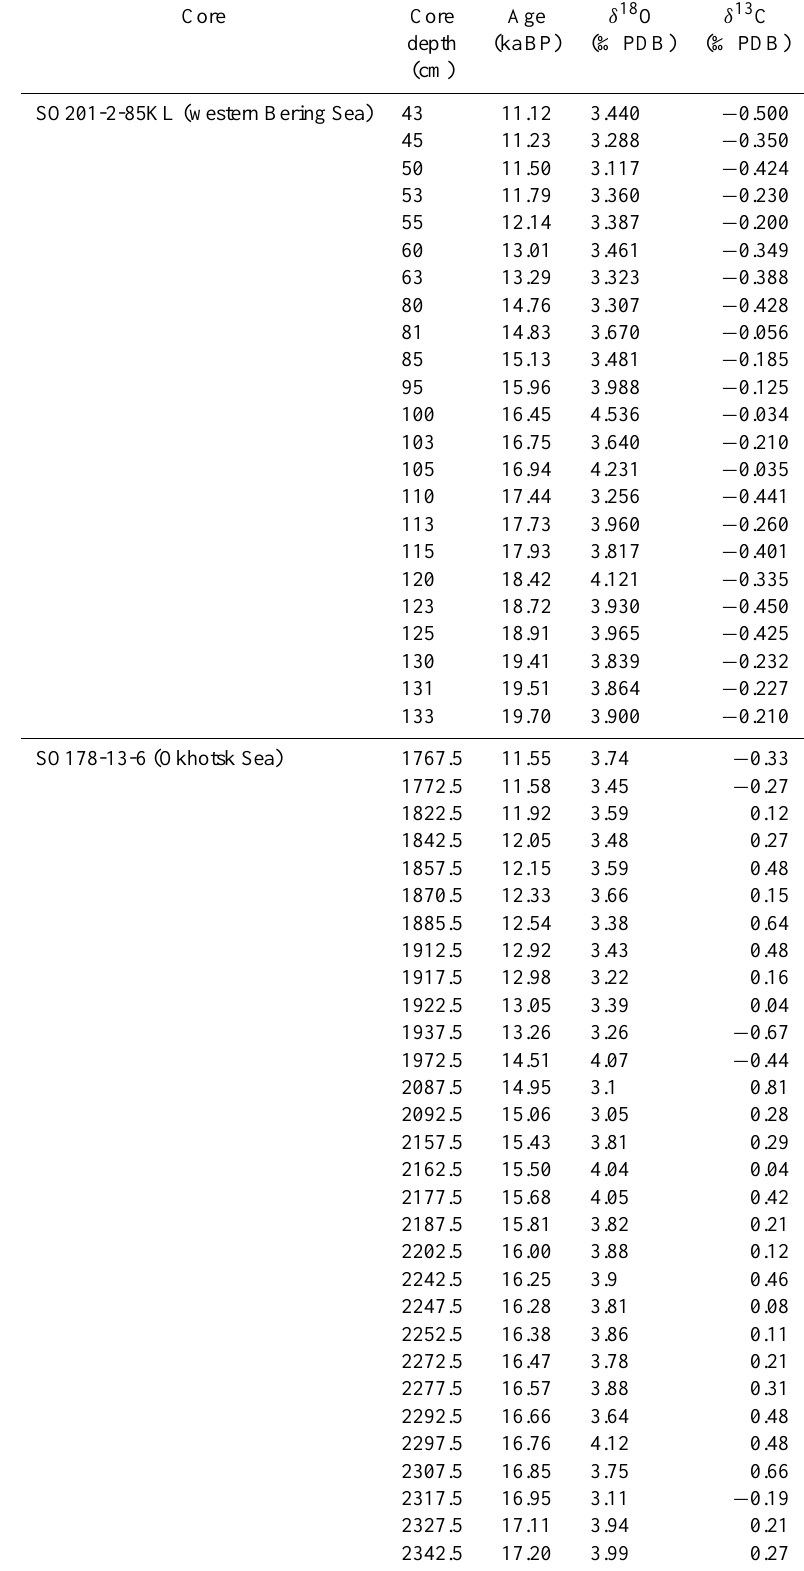
Table 1. Stable isotope measurement results ( δ 18 O; δ 13 C) derived from epibenthic foraminifera Cibicides lobatulus